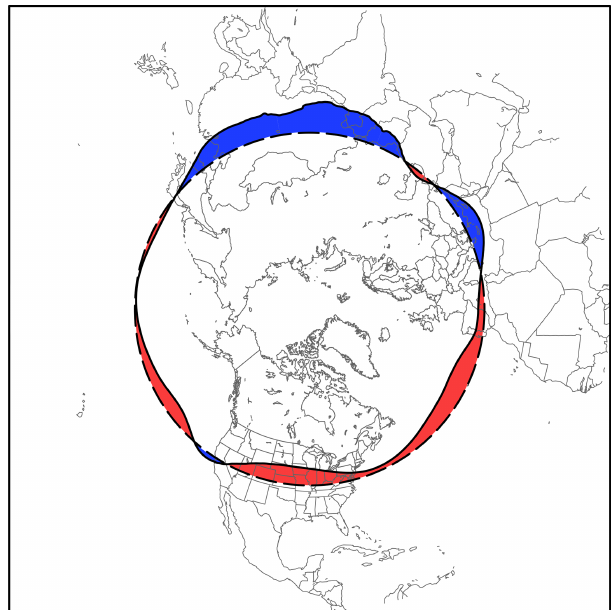
Figure 1. Anticyclonic local finite-amplitude wave activity (red) and cyclonic local finite-amplitude wave activity (blue) for the GCM2000 simulation based on the 25-year GCM2000 JJA average 5850m geopotential height at 500hPa (black contour). The dashed contour represents the equivalent latitude for this contour. At the equivalent latitude the magnitude of the local wave activity varies with longitude in proportion to the displacement of the black con- tour from the dashed contour. The total LWA( λ, φ e ) is equal to the cyclonic wave activity minus the anticyclonic wave